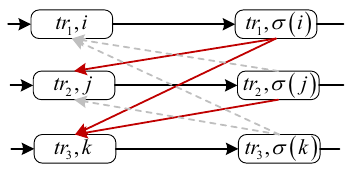
Figure 3. Situation where